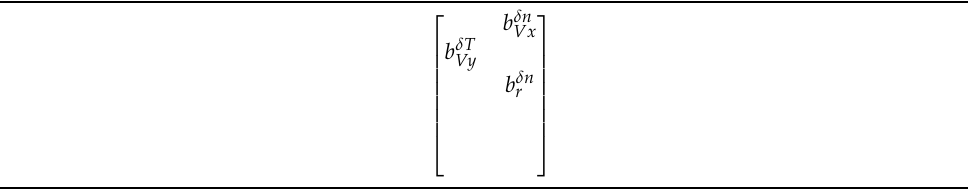
Table 4. Command matrix for longitudinal motion in ascending/descending evolution B